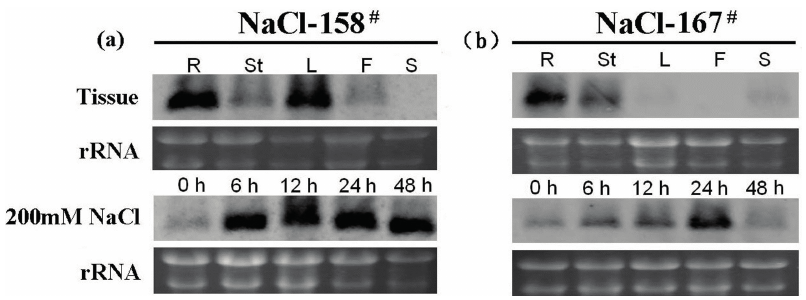
Figure 4. Expression analysis of NaCl-158 # and NaCl-167 # by northern blot